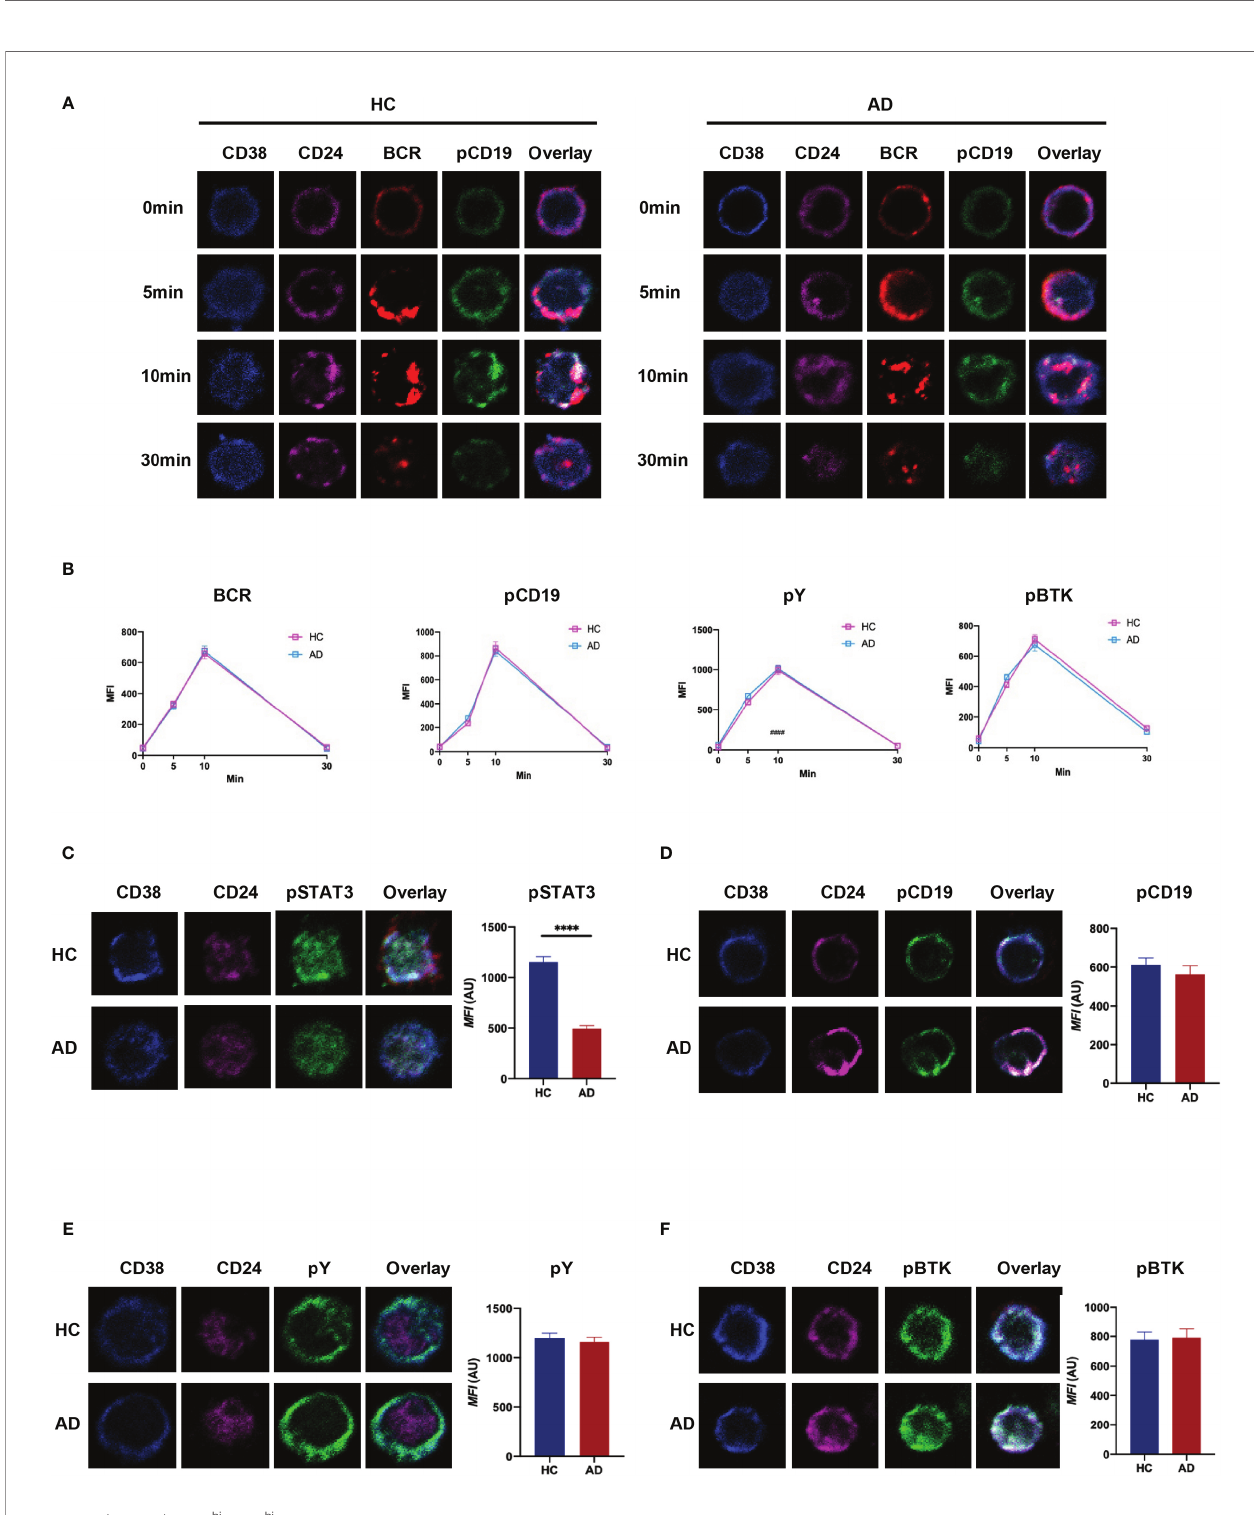
FIGURE 5 | CD19 + CD24 hi CD38 hi B cells from patients with EAD regulate BCR signaling normally but show impaired TLR-STAT3 signaling. (A) B cells were incubated with AF546-(Fab)2-anti-Ig(M+G), to mimic the antigen, for 30 min on ice to label the BCR, and then stimulated at 37°C for different times. (B) Analysis of the MFI of BCR, pCD19, pY, and pBtk in CD24 hi CD38 hi B cells after stimulation with soluble antigen. (C – F) B cells from patients with EAD or HC were stimulated for 48 h by CpG and incubated with AF546-(Fab)2-anti-Ig(M+G) for 30 min. The MFI of pSTAT3, pCD19, pY and pBtk in CD24 hi CD38 hi B cells was analyzed. Data are expressed as the means ± SEM. ****P < 0.0001 (Mann-Whitney U -test). Representative images are shown; in which more than 50 cells were individually analyzed using NIS-Elements AR 3.2 software. Data are representative of three independent